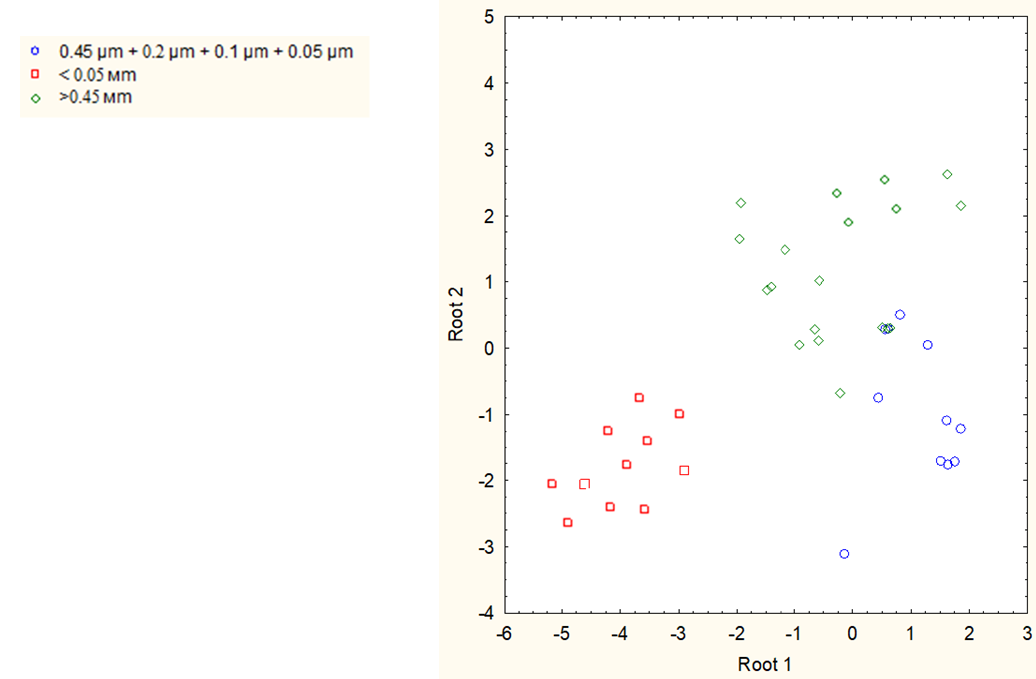
Figure 4. Discriminant analysis results for selected filtration diameters.